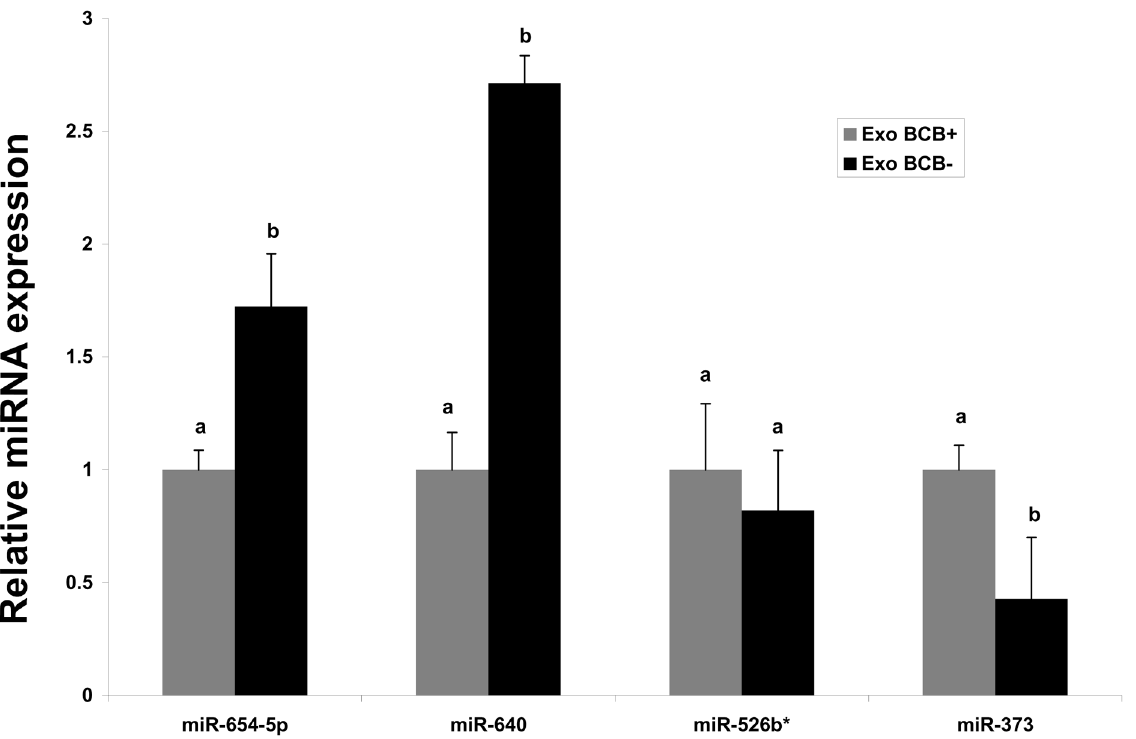
Figure 7. Validation of the enrichment of candidate miRNAs in exosomes taken up by granulosa cells. Purified exosomes from follicular fluid of follicles with growing (BCB-) or fully grown (BCB + ) oocytes were subjected to total RNA extraction. Then the expression level miR-654-5p and miR-640 (enriched in exosomes derived from BCB- follicular fluid) and miR-526b* and miR-373 (enriched in follicular fluid derived from follicles with BCB + oocyte) were investigated by real time PCR. Different superscript letters (a,b) denote a significant difference between groups, such that groups not sharing a similar letter are significantly different form each other (P , 0.05). The data is presented as means 6 s.d. of three biological replicates.